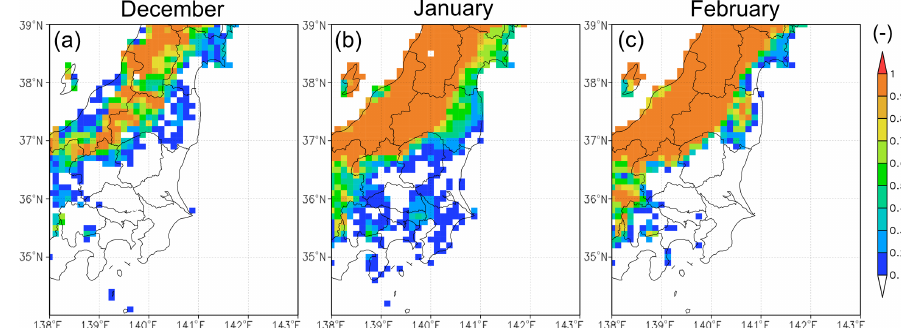
Figure 9. Monthly mean MODIS snow cover fractions interpolated to the model grid